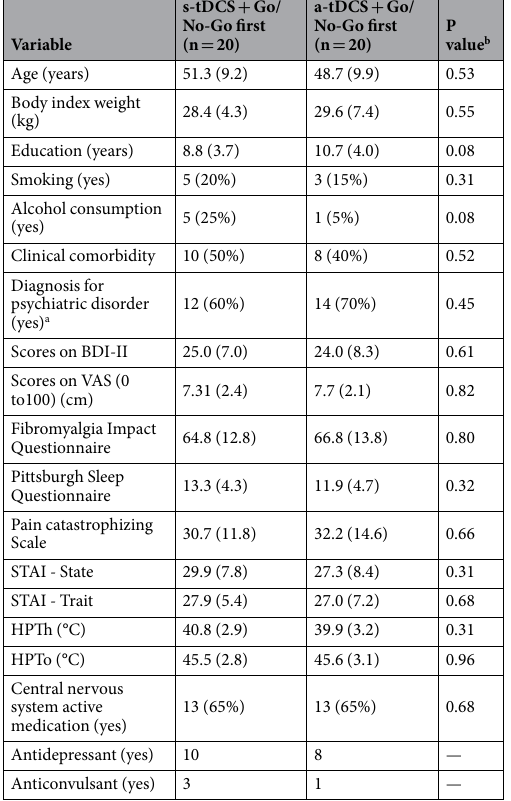
— Table 1. Sample Characteristics at Baseline, According to Group and Phase. Values are given as mean (SD) or frequency (%) (n = 40). Notes: BDI-II: Back Depression Inventory II; VAS: visual analog scale; STAI: State Trait Anxiety Inventory. a Based on the Structured Clinical Interview for DSM-IV Axis I Disorders (SCID-I). Patients could have none or more than one psychiatric disorder. b Independent samples t-Tests for mean values and Chi- Square or Fisher’s tests for frequency